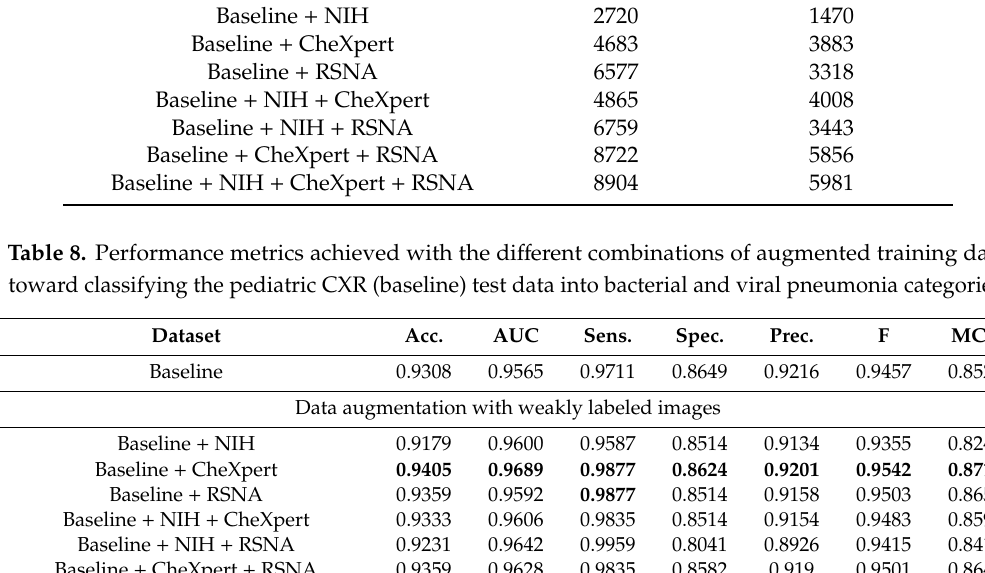
Bold numerical values denote superior